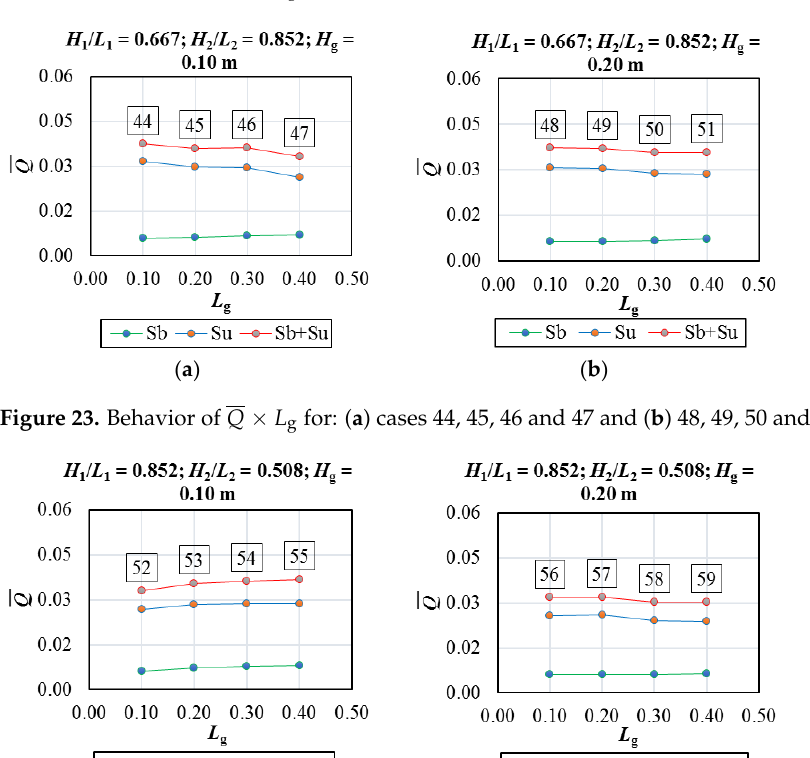
Figure 22. Behavior of Q ̅ × L g for: ( a ) cases 36, 37, 38 and 39 and ( b ) 40, 41, 42 and 43.